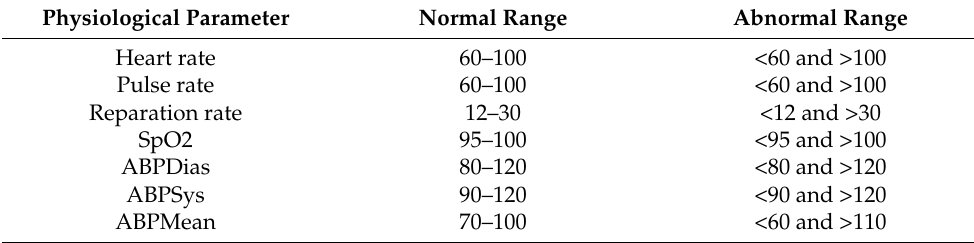
Table 5. Physiological data normal and abnormal ranges